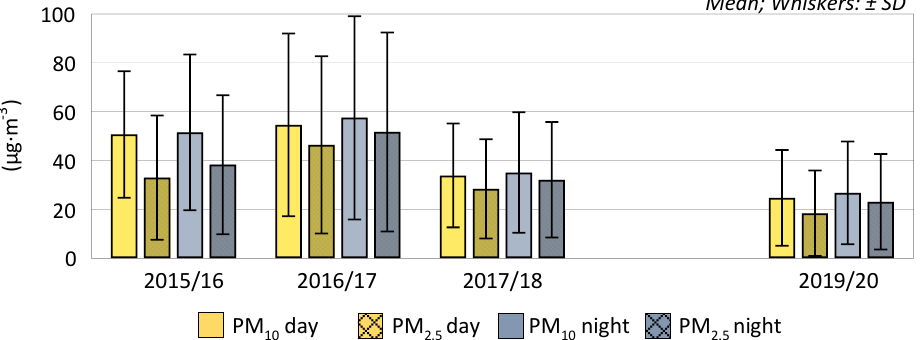
Figure5. Averageconcentrations( µ g · m –3 )ofPM 10 andPM 2.5